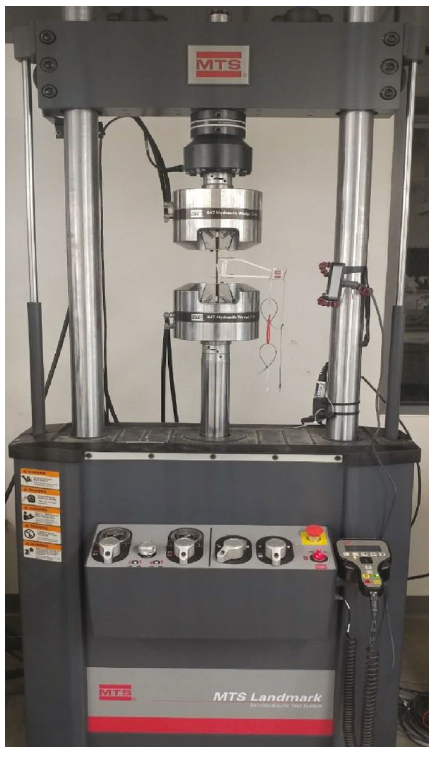
Figure 2: Tensile testing